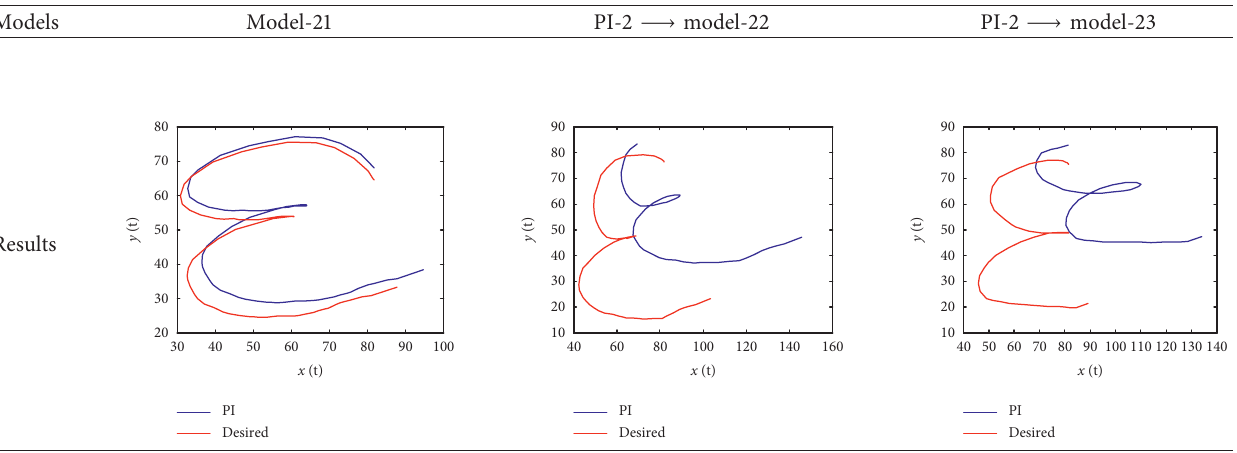
Table 5: Results of validation of the PI-2 controller applied to model-21, model-22, and